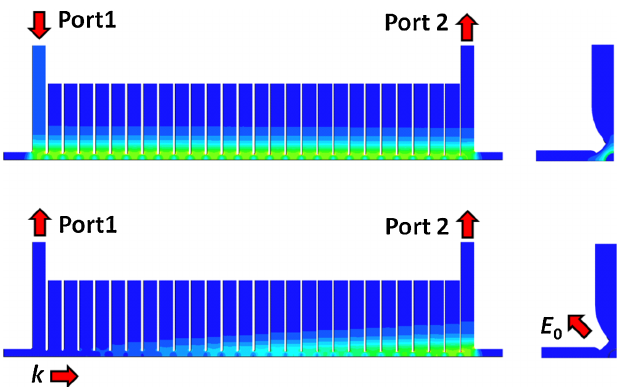
FIG. 1. Electric field distribution in 1 = 4 of the accelerating structure calculated for two cases: port excitation (top) and plane wave excitation